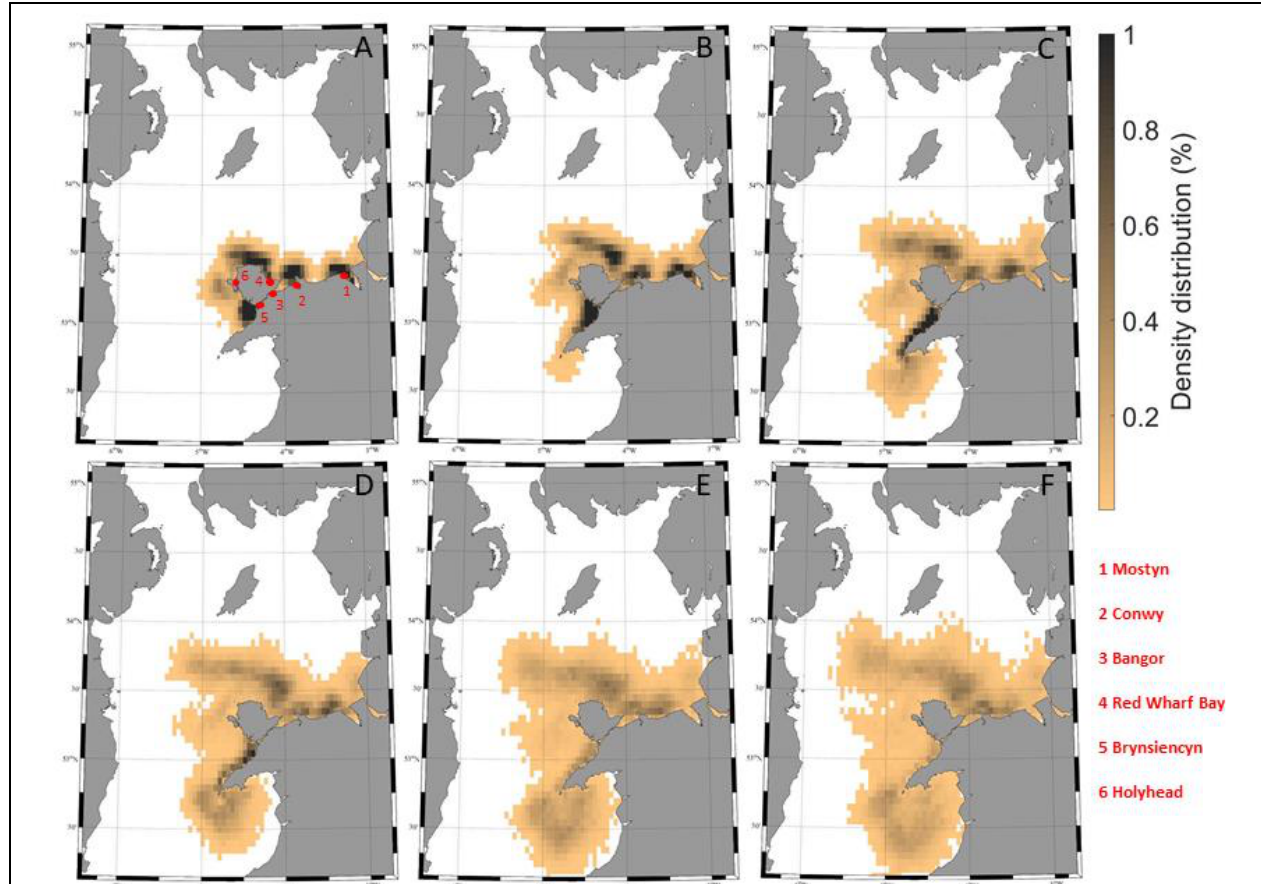
Fig. 3. Maps showing the density distribution of mussel larvae released at the midwater column in March-April 2018 (advected by tide only) from 6 released areas (red dots) during: (A) week 1; (B) week 2; (C) week 3; (D) week 4; (E) week 5 and (F) week